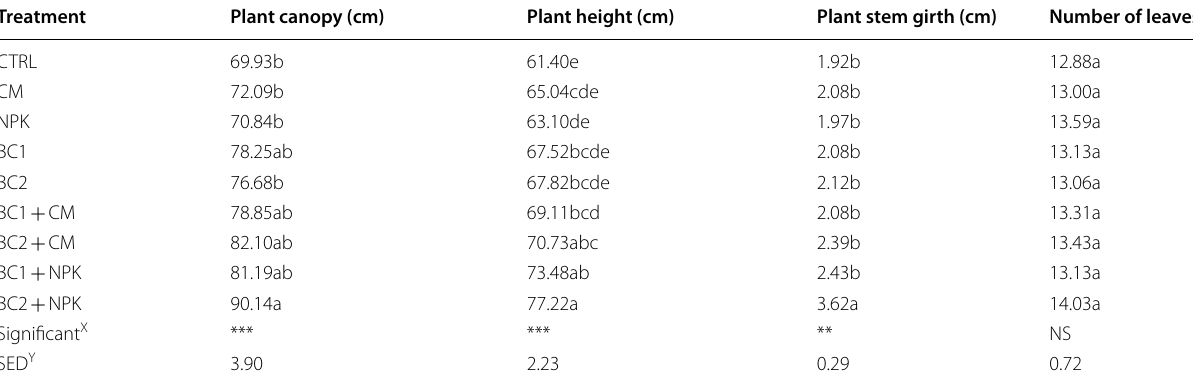
Table 8 Residual effects of co-applied biochar with compost and/or NPK collard plant canopy, plant height, plant stem and the number of leaves at 60